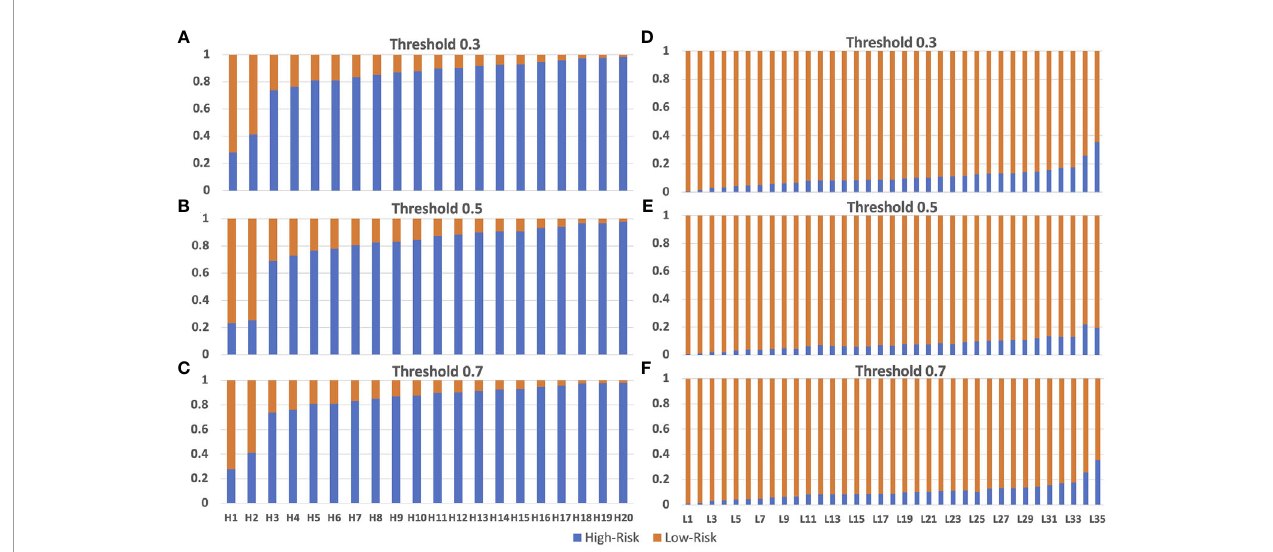
FIGURE 5 | Model testing using the independent testing set ofhigh-risk andlow-risk patients. Panel (A – C) are fromthe truely high-risk patients. Panel (D – F) are from the truely low-risk patients. Model prediction for high-riskpatients with threshold 0.3 (A) , 0.5 (B) and 0.7 (C) had incorrect preditionson patients H1 and H2 which is lower than 0.5. Model prediction for low-riskpatients with threshold 0.3 (D) , 0.5 (E) and0.7 (F) are 100% correct on alllow-riskpatients. The size of the bar with color corresponding to the correct prediction isthe accuracy ofthe model.Blue color and orange color represent for high-risk and low-risk